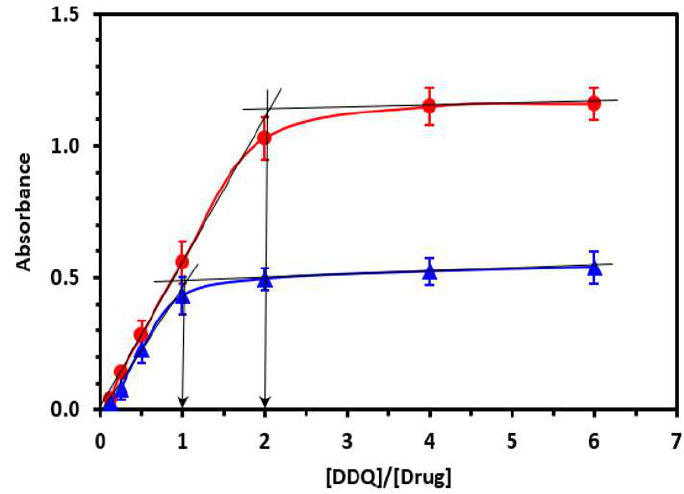
Figure 7. Plots of absorbance versus molar ratio of [DDQ]/[Drug] obtained from reaction mixtures of fixed concentrations of DUV ( (cid:78) ) and SEL ( • ) with varying concentration folds of DDQ. The mole ratio was assigned as the point of intersection of the tangents of straight-line portions of the plots. These findings led to the hypothesis that the CT interaction of DUV and SEL with DDQ would progress as shown in Figure 8.